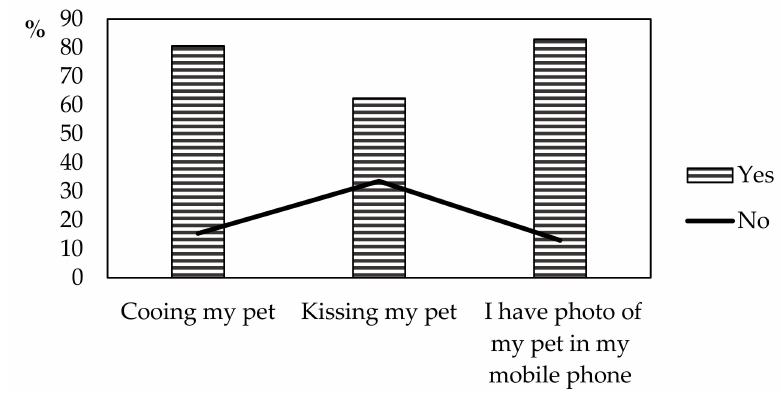
Figure 1. Student relationship (n = 505) with their own pet.